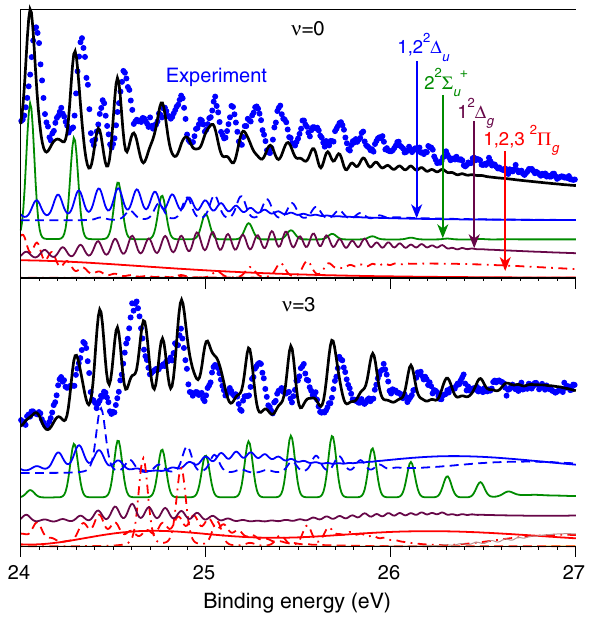
FIG. 6. The details of the experimental and theoretical RPE spectra (Fig. 4) in the binding-energy range of 24–27 eV. The excitation energies and line notations are the same as in Fig.